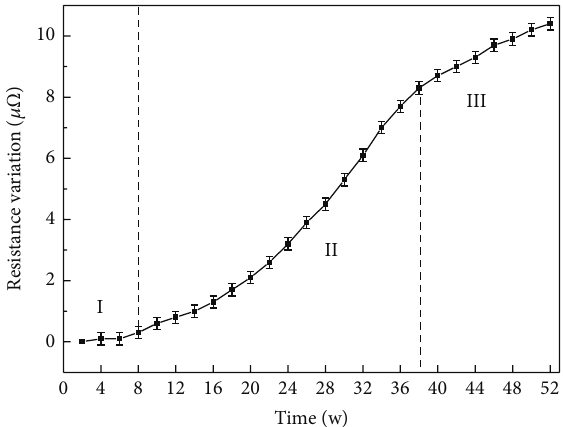
Figure 3: Variation curve of resistance addition for clubbed X80 steel in acidic red soil for 52 weeks.